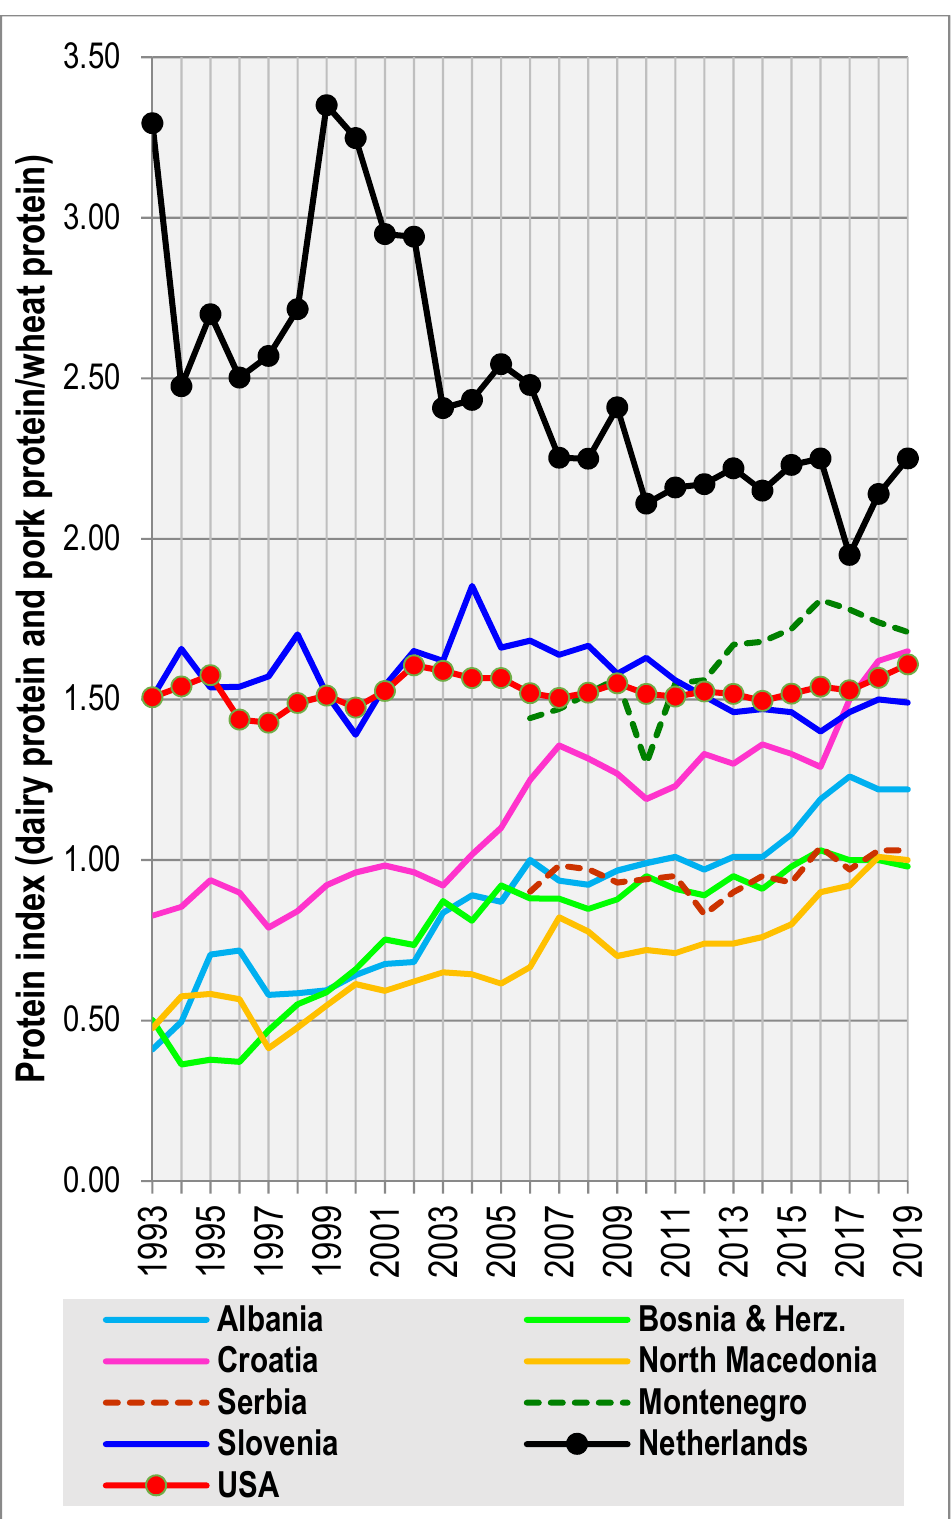
Figure 4. The quality of nutrition in the Western Balkans (expressed as the ‘protein index’), compared with the Netherlands and the USA. Source: [25]. Note: Data for 2010–2019 were computed using the new FAOSTAT